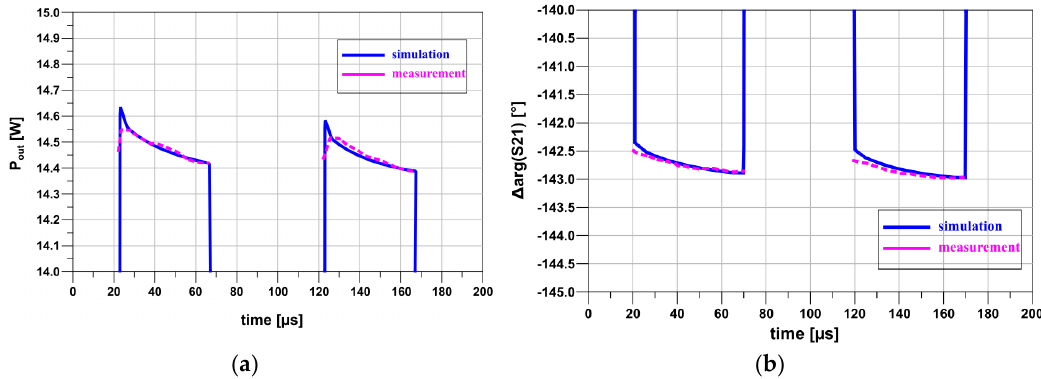
Figure 10. Transmittance changes of the amplifier: ( a ) amplitude changes, ( b ) phase changes during pulse for carrier frequency f = 1.05 GHz.